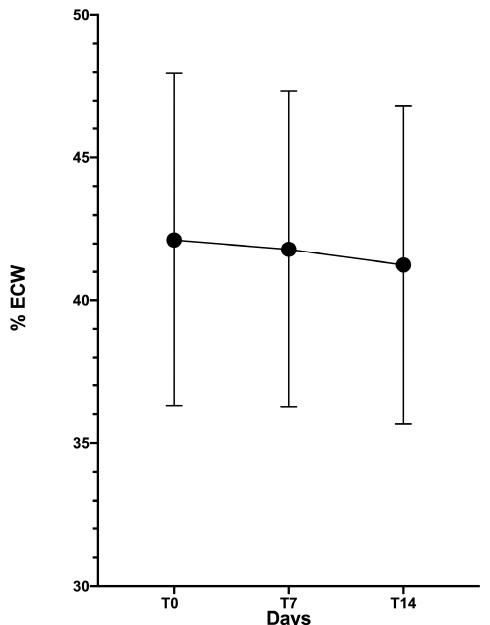
Figure 1. Decreasing in extracellular water rate (% ECW) from baseline (T0); to 7 days (T7) and 14 days (T14).